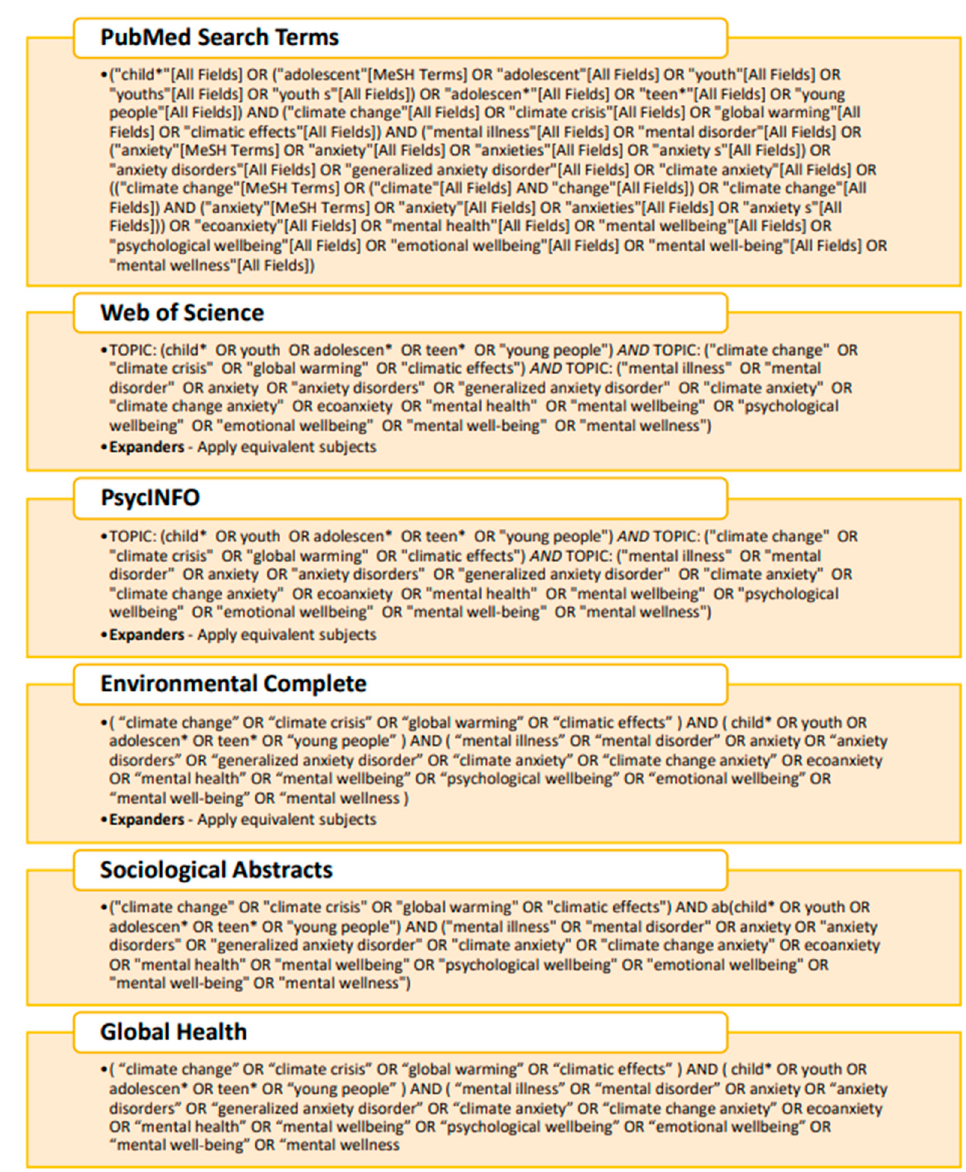
Figure 1. Keyword search strategy.